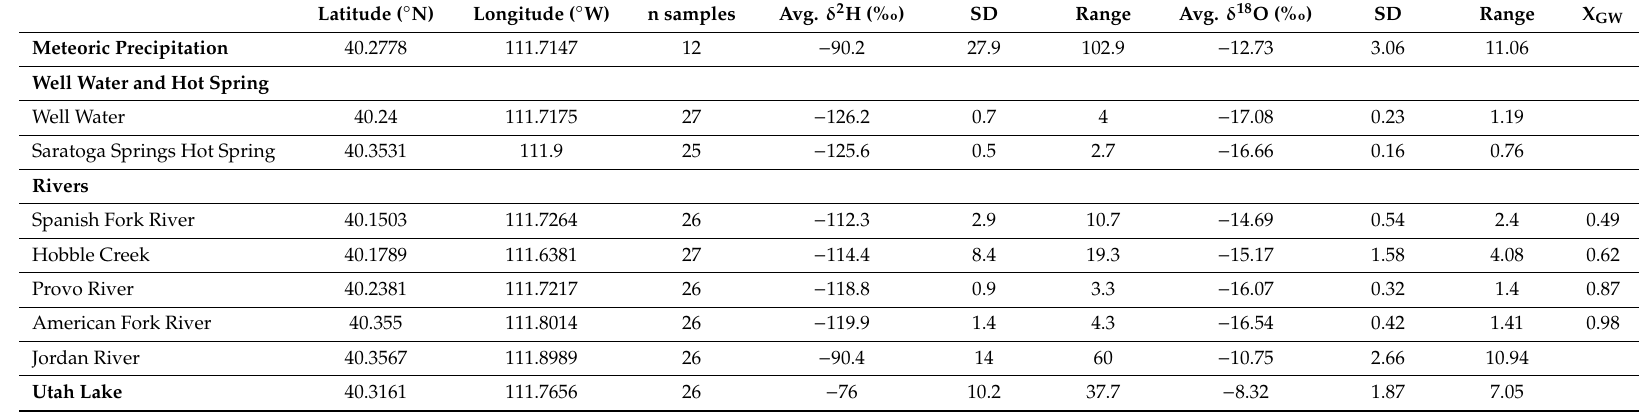
Table 1. Summary descriptive statistics for the δ -values of meteoric precipitation and of the biweekly samples. X GW is the average fraction of groundwater vs. meteoric precipitation present in the stream flow of each inlet. Latitude and longitude are referenced to the WGS (World Geodetic System) 84 datum. Latitude ( ◦